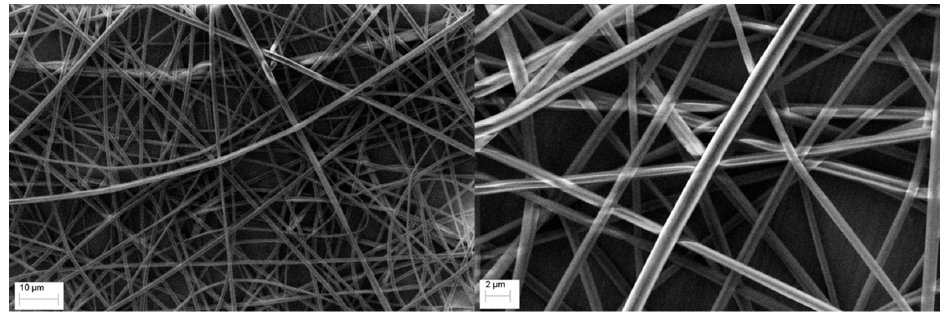
Figure 1. Scanning electron microscopy images of the electrospun poly(SDIB)/PMMA fibers. The average diameter of the fibers was determined to be 0.970 ± 0.220 µm .